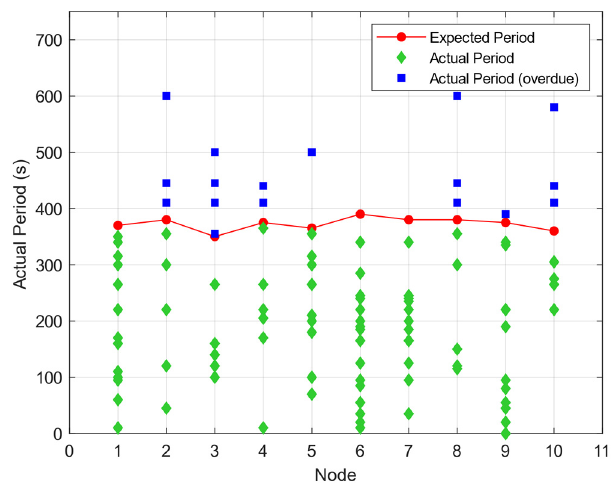
Figure 7. The actual monitoring period of each node obtained by ACO algorithm.